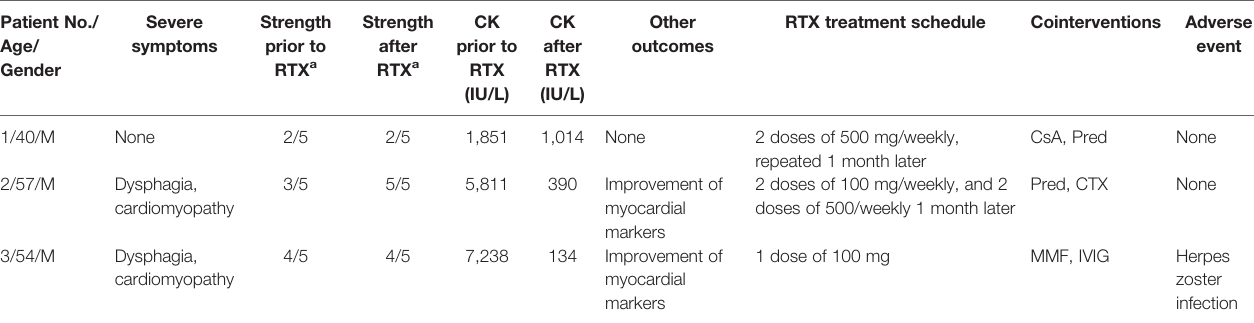
TABLE 2 | Retrospective review of patients with anti-SRP IMNM treated with anti-B-cell therapies in a single center. Patient No./